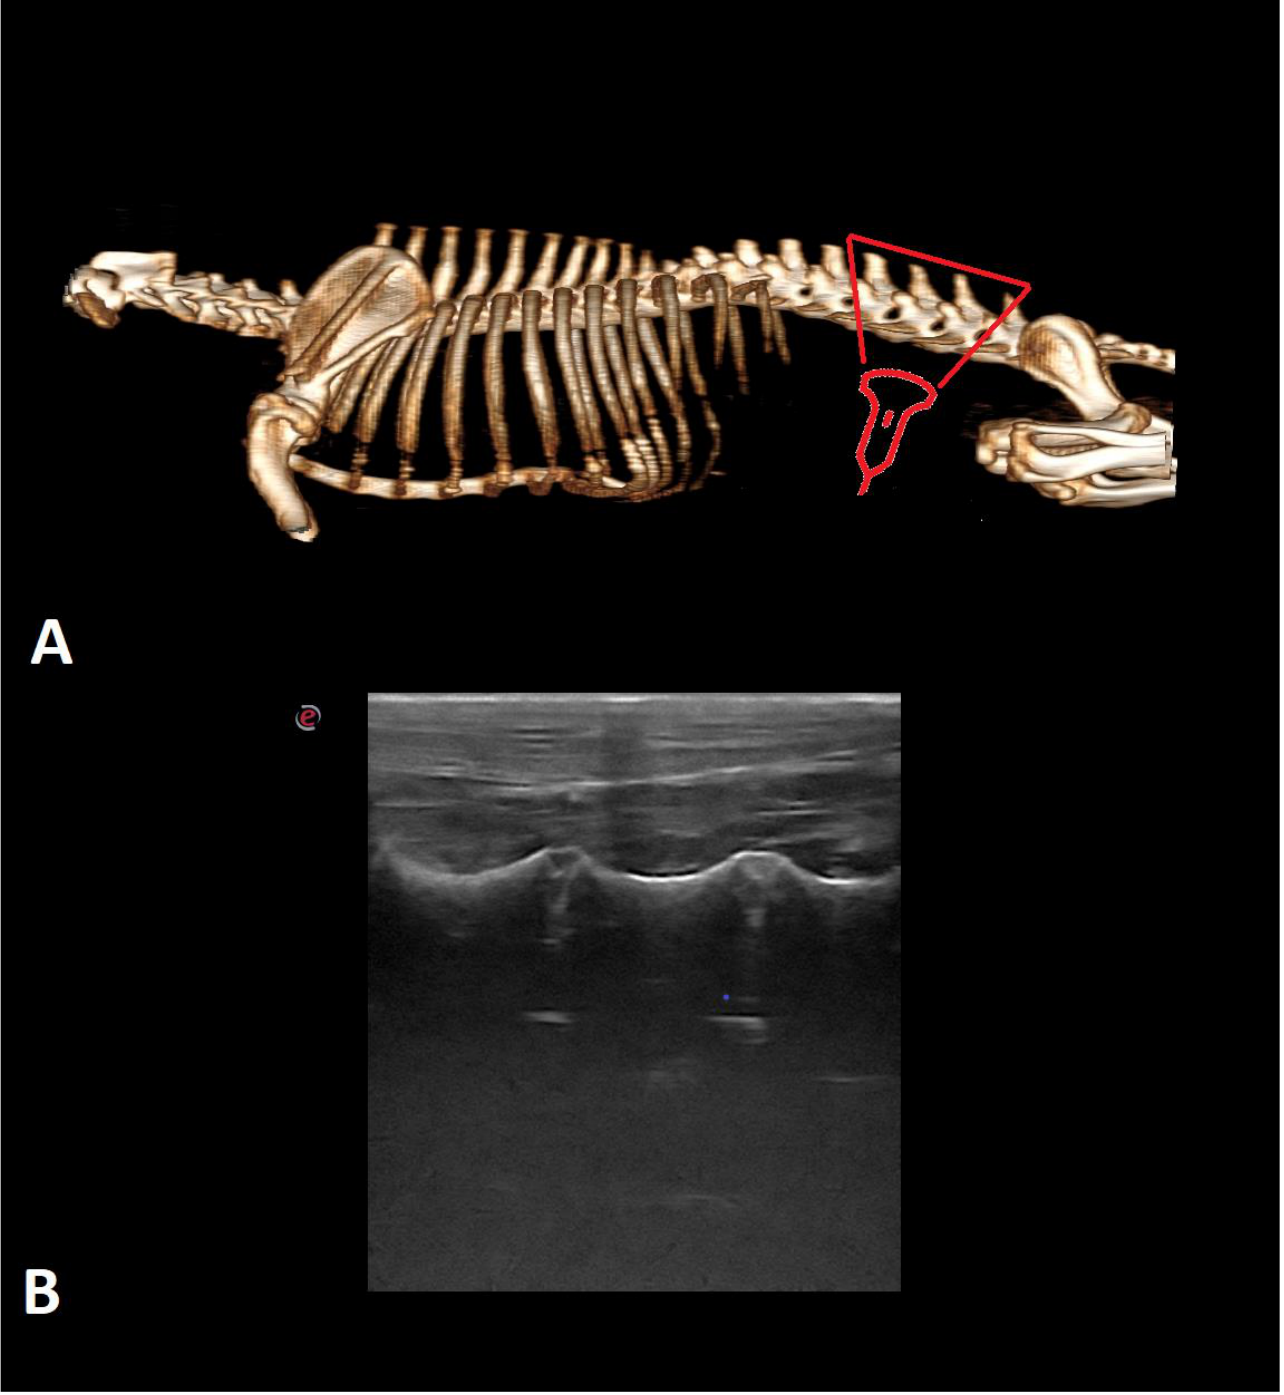
Figure 4. The 3D CT scan ( A ) and ultrasonographic image of the longitudinal paramedian plane on ventral side ( B ) of the lumbar spine of the dog. A red triangle indicates the place in the spine where the probe is applied.